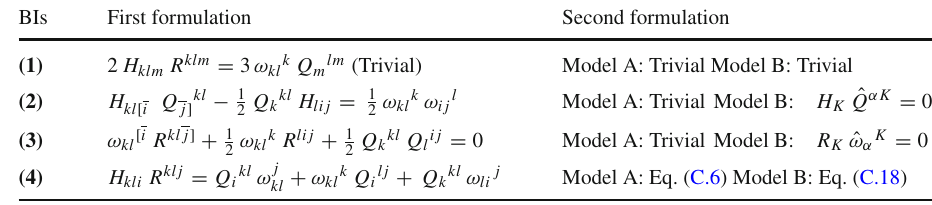
BIs First formulation Second